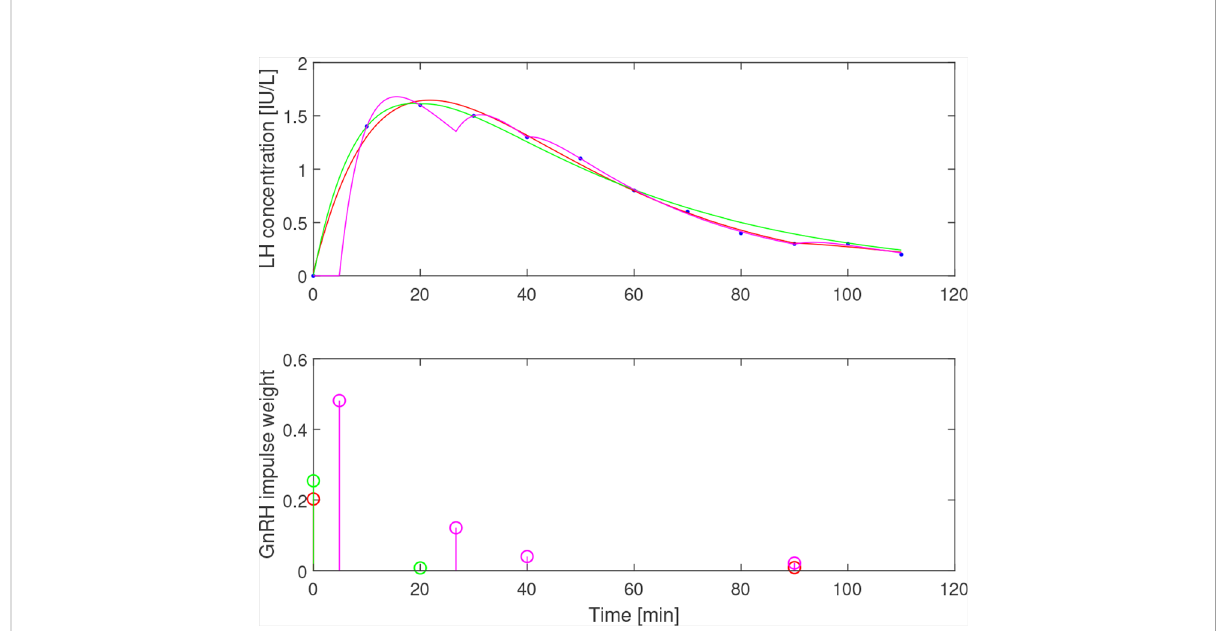
FIGURE 7 Simulated LH concentration (top) together with measured values (blue dots) and GnRH-impulses (bottom) from estimation assuming b 1 =0.05 (red), b 1 =0.1 (green) and b 1 =0.2 (magenta). Varying b 1 results in qualitatively different impulse distributions, yet all three choices give a reasonable fi t to the